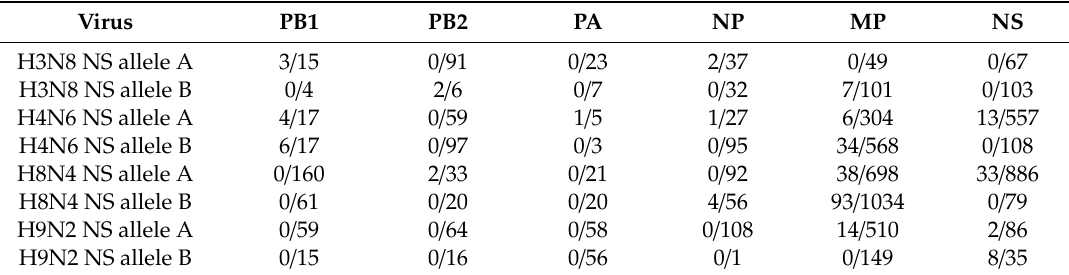
Table 2. Genetic cluster analysis of the inoculated viruses. Clusters of internal genes similar to those of the inoculated viruses, presented as the number of sequences that originate from poultry out of the total number of sequences within each cluster (cluster size). Genetic clusters were generated by